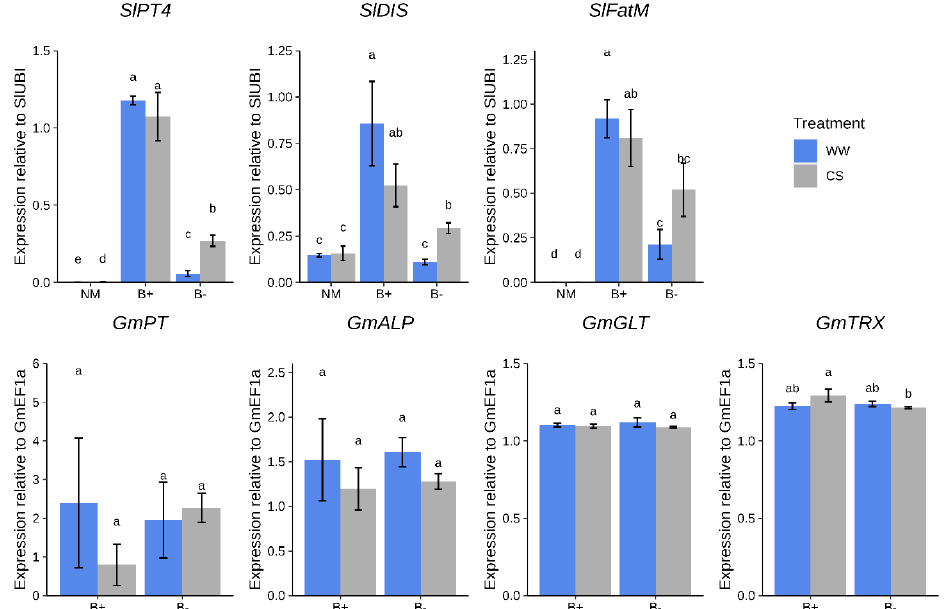
Figure 4. Expression profiles of marker genes in tomato roots colonized by G. margarita at 90 days after inoculation. Differences are indicated with different letters according to Kruskal–Wallis test ( P < 0.05). CS = combined water/nutrient stress, WW = normal conditions. Plant genes: SlPT4, SlDIS; SlFatM; G. margarita genes: GmPT , GmALP , GmGLT, GmTRX.